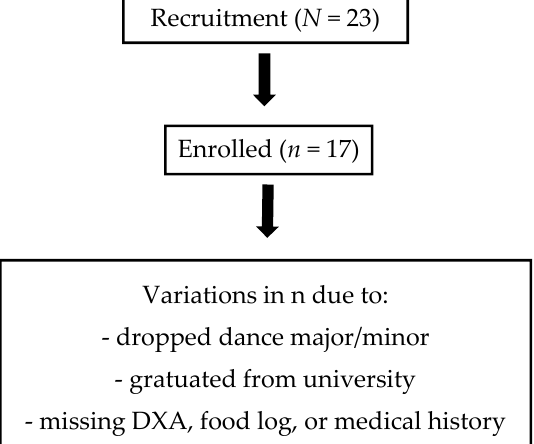
Figure 1. Variation in Participant Sample